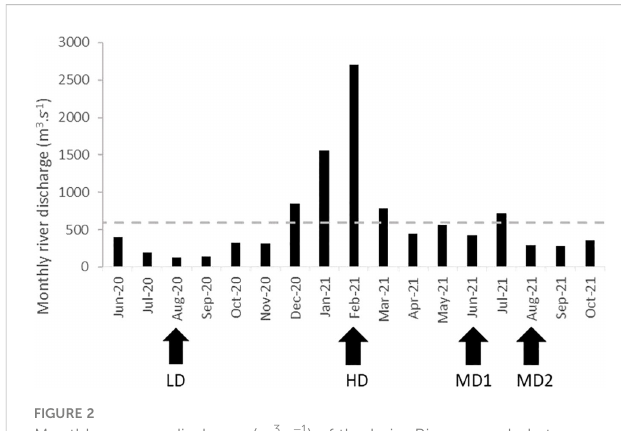
FIGURE 2 Monthly average discharge (m 3 s − 1 ) of the Loire River recorded at Mont-Jean sur Loire (France). Data provided by Hydroportail (Hydro, 2021). The dotted line indicates the mean annual discharge. Arrows indicate different sampling